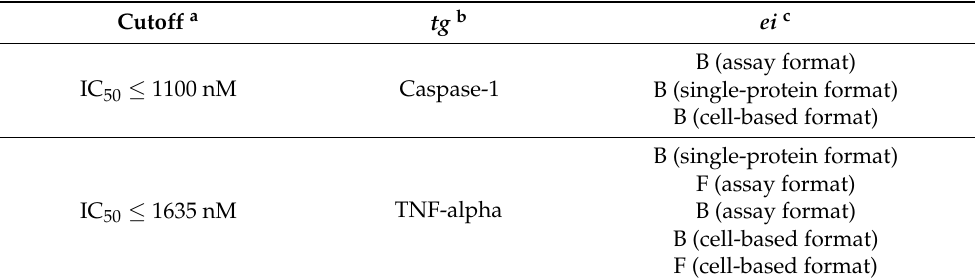
Table 1. Experimental conditions under which the molecules were assayed against caspase-1 and TNF-alpha. Cutoff a tg b ei c IC 50 ≤ 1100 nM Caspase-1